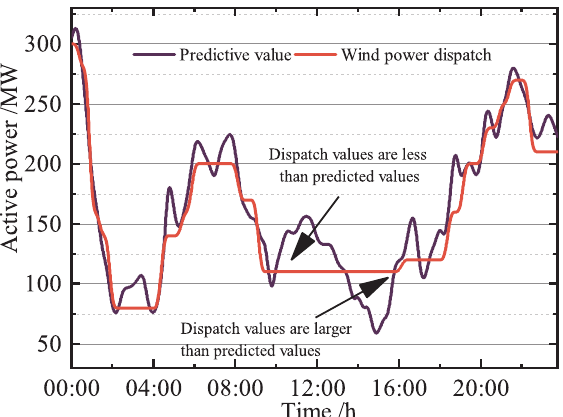
Figure 9. Wind power cluster curve of forecasting and